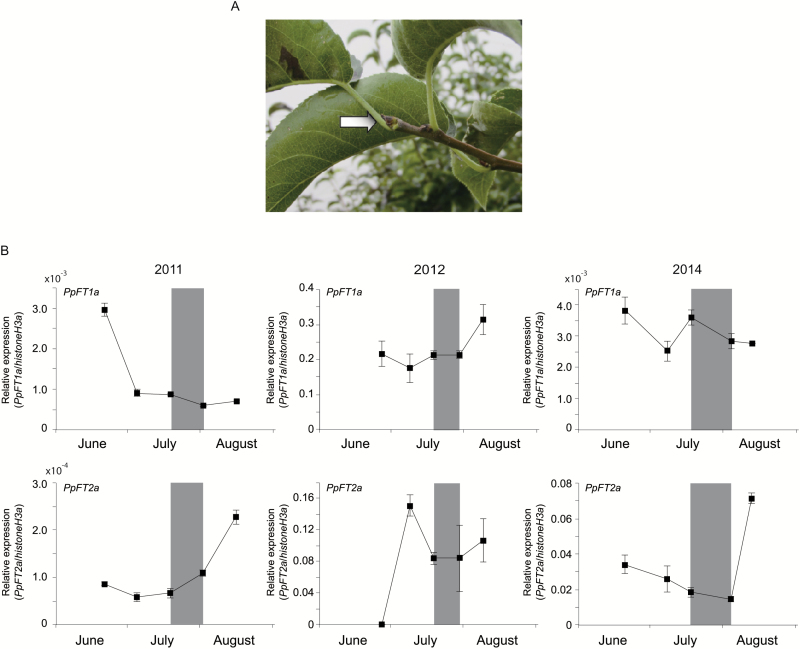
Apical tips/buds of newly grown long shoots (A; white arrow) and relative expression levels of PpFT1a and PpFT2a genes in ‘Kosui’ from June to August in 2011, 2012, and 2014 (B). Error bars indicate standard error of three technical replicates. The stage that a dome-like structure (indicating occurrence of visible floral initiation) appeared is indicated by the grey zone. (This figure is available in color at JXB online.)